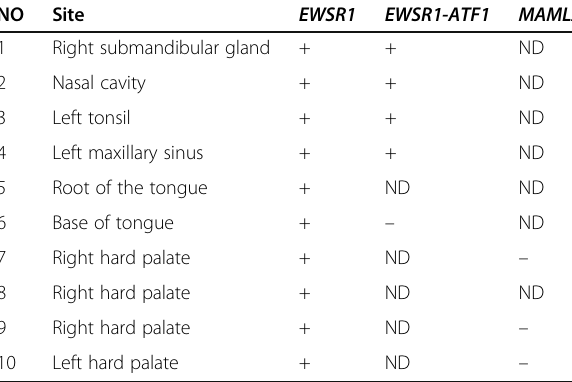
Table 3 FISH detection results in 10 cases of CCC